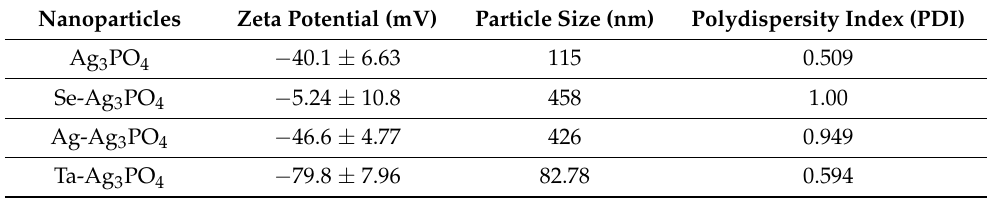
Figure 2. SEM images of Ag 3 PO 4 ( a ), Se-Ag 3 PO 4 ( b ), Ag-Ag 3 PO 4 ( c ), and Ta-Ag 3 PO 4 ( d ). Zeta potential is a unique technique for determining the surface charge and stability of the nanoparticles. The zeta potential of Ag 3 PO 4 , Se-Ag 3 PO 4, Ag-Ag 3 PO 4 , and Ta-Ag 3 PO 4 nanoparticles is presented in Figure S5. The zeta potential of Ag 3 PO 4 , Se-Ag 3 PO 4, Ag-Ag 3 PO 4 , and Ta-Ag 3 PO 4 nanoparticles was observed as − 40.1 ± 6.63, − 5.24 ± 10.8, − 46.6 ± 4.77, and − 79.8 ± 7.96 mV, respectively. The zeta value greater than +30 mV or less than − 30 mV indicated the stable colloidal dispersion. Our results revealed the high dispersion stability of Ta-Ag 3 PO 4 nanoparticles followed by Ag-Ag 3 PO 4 , and Ag 3 PO 4 , while Se-Ag 3 PO 4 nanoparticles indicated low stability. The particle size of Ag 3 PO 4 , Se-Ag 3 PO 4 , Ag-Ag 3 PO 4 , and Ta-Ag 3 PO 4 nanoparticles was recorded as 115 (PDI: 0.509), 458 (PDI: 1.00), 426 (PDI: 0.949), and 82.78 nm (PDI: 0.594), respectively (Table 1). The results indicated that Se-Ag 3 PO 4, and Ag-Ag 3 PO 4 nanoparticles have bigger particle size as compared to Ag 3 PO 4 , and Ta-Ag 3 PO 4 nanoparticles. The polydispersity index (PDI) as well as the particle size of Ag 3 PO 4 and Ta-Ag 3 PO 4 was observed as lower, indicating their greater suitability for biomedical applications. Table 1. Zeta potential, particle size, and polydispersity index of synthesized nanoparticles.